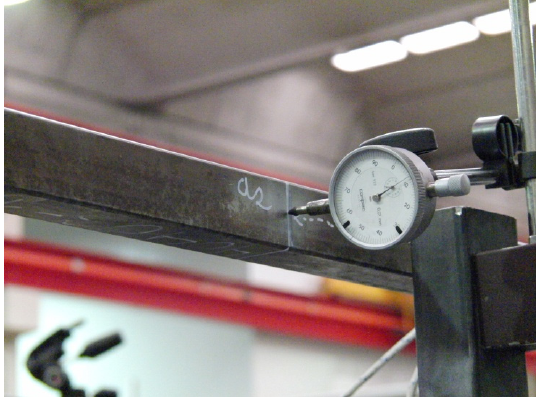
Figure 8. Mounting of the dial gauge for the displacement measurement of the a2 section.